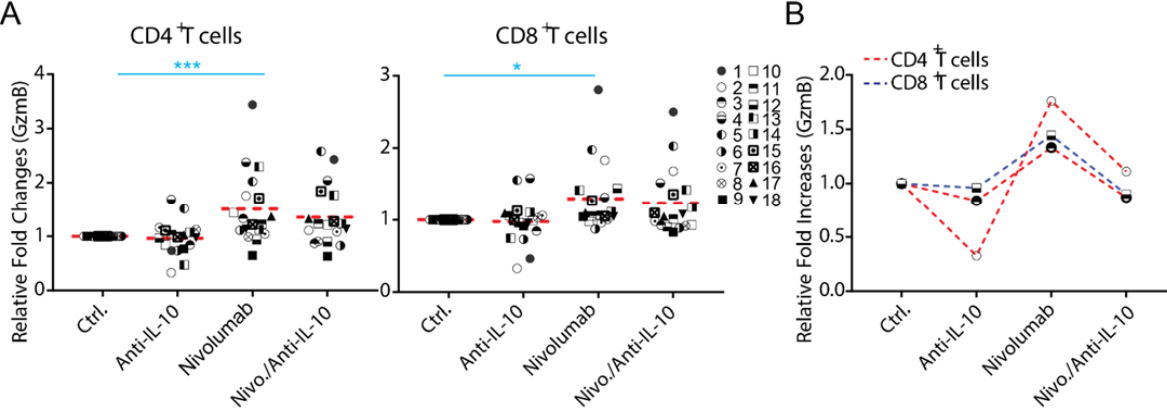
Figure 4. Anti ‐ interleukin ‐ 10 (anti ‐ IL ‐ 10) mAb induces heterogeneous expression of Granzyme B (GzmB) in CD4 + and CD8 + T cells. ( A , B ) Purified T cells were co ‐ cultured with allogeneic monocyte ‐ derived dendritic cells in the presence of nivolumab (20 μ g/mL) with or without anti ‐ IL ‐ 10 mAb (5 μ g/mL) for 5 days, after which cells were harvested for flow cytometry analysis of Granzyme B expression. ( A ) Donor pairs showing that anti ‐ IL ‐ 10 mAb decreased nivolumab ‐ modulated expression of Granzyme B in CD4 + and CD8 + T cells are shown. Graphs show the relative fold change over the no ‐ antibody treatment controls. ( B ) Donor pairs with two ‐ fold changes between nivolumab and nivolumab plus anti ‐ IL10 mAb treatment are shown. Each symbol represents data from an individual donor pair. Student’s t ‐ test, * p < 0.05, *** p < 0.001.